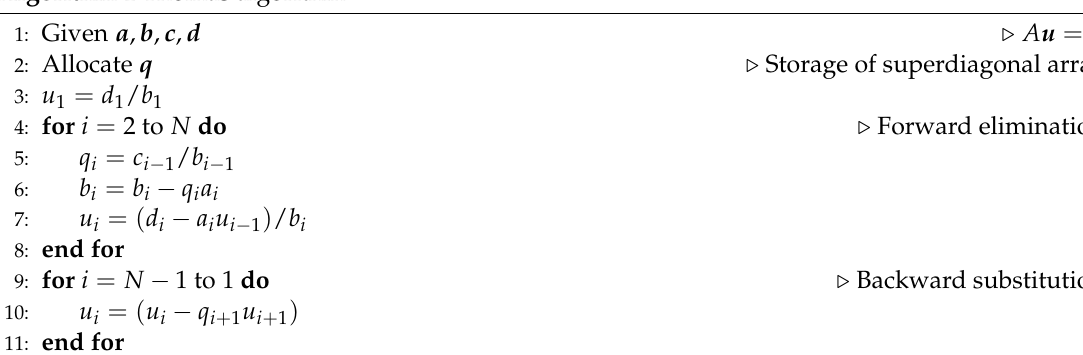
Algorithm 1 Thomas